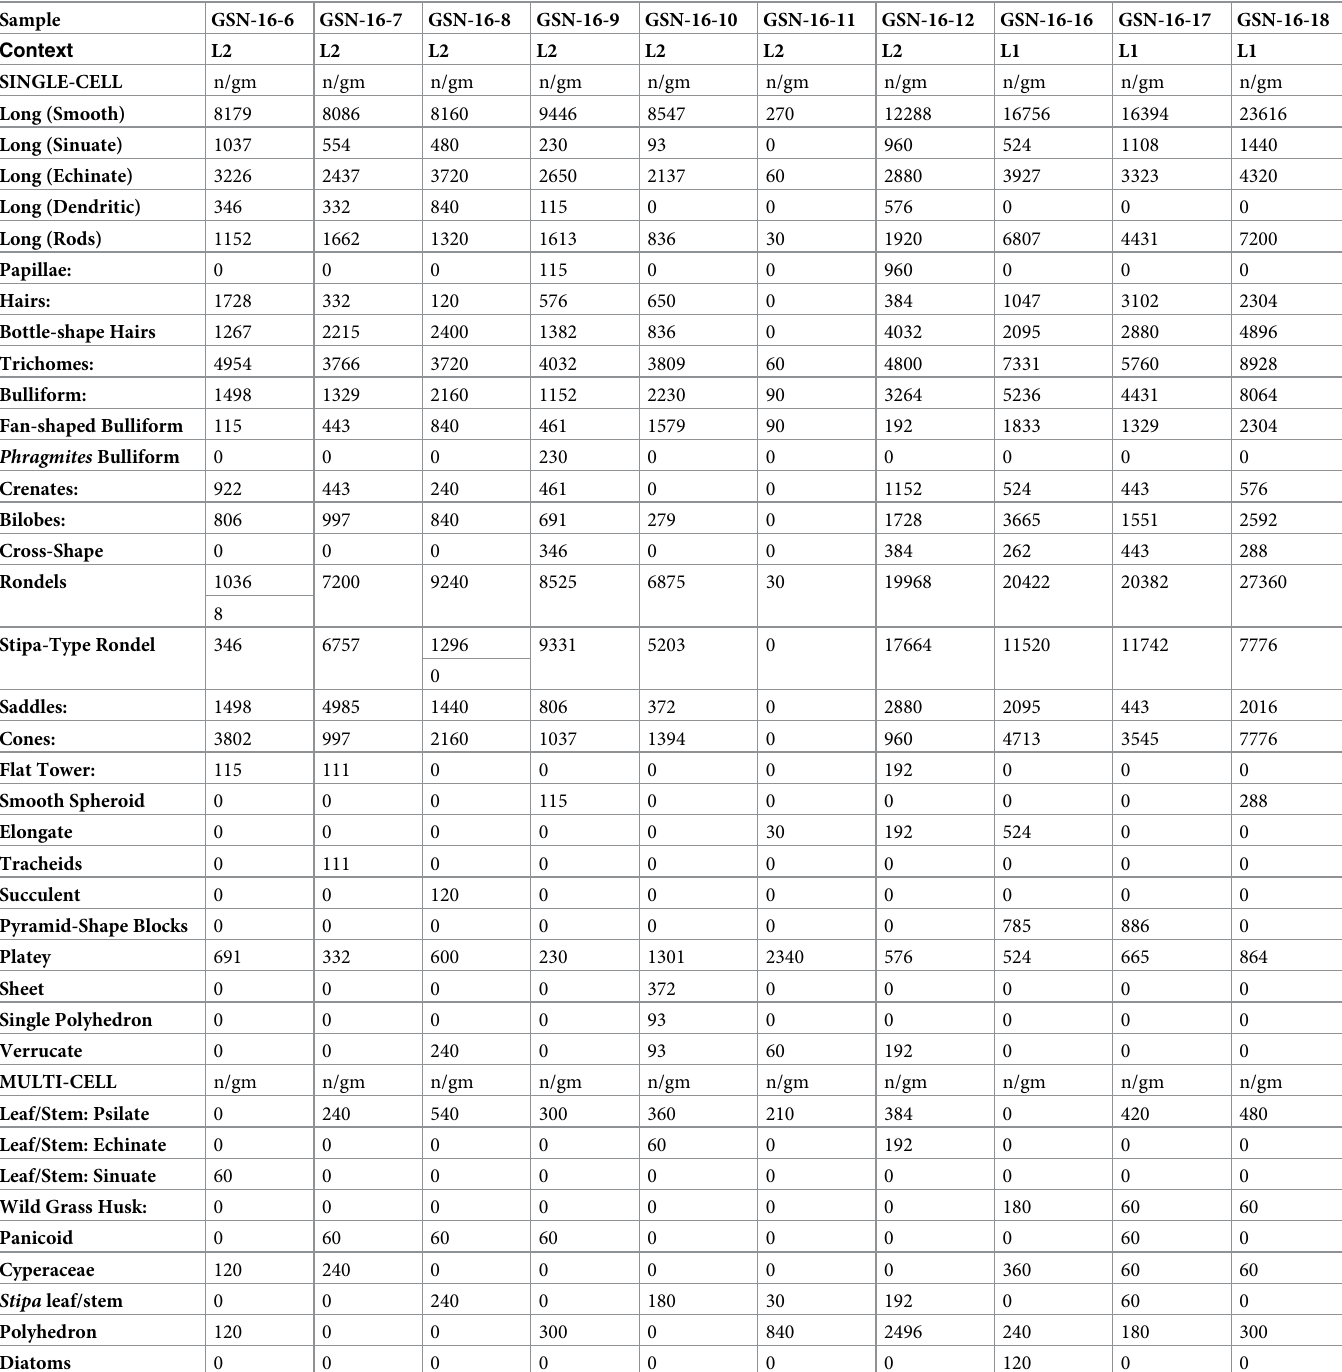
Table 3. Absolute phytolith counts in numbers per gram of sediment for Zaraa Uul Locus 1 and Locus 2.